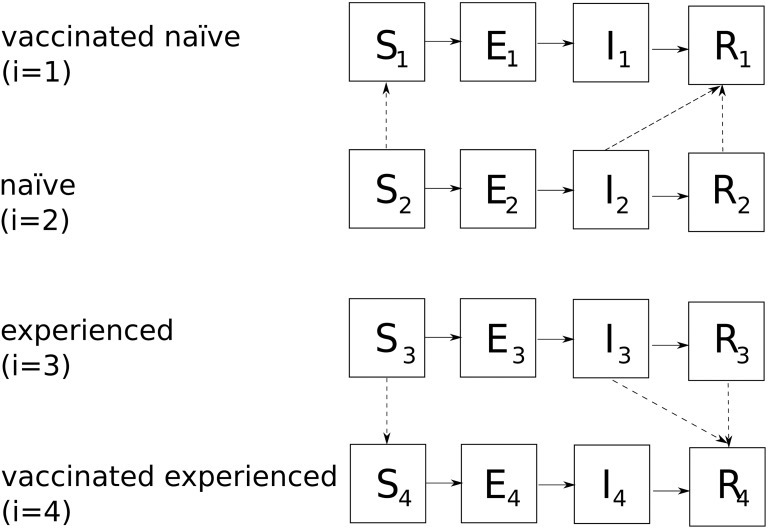
Model structure.Susceptible hosts are divided into 4 strata (labelled by i) depending on their prior influenza experience and vaccination status. Susceptible hosts S
i become exposed (E
i) at a rate proportional to β
f, become infectious (I
i) with Erlang distributed waiting time with rate parameter γ = 1/(1.3 days) and recover (R
i) at a rate ν = 1/(1.6 days). Dashed lines indicate the vaccination of hosts. Note we assume that vaccines do not alter the infectiousness of already exposed hosts (although this distinction is of little consequence if vaccination occurs very early in a pandemic). We allow for the possibility of strain-specific antibody to the pandemic strain by assuming that some (experienced) hosts begin in the recovered state R
3. We assume infected-acquired immunity is maintained over the course of the simulation, however in practice as immunity wanes recovered hosts who were originally naïve migrate to the appropriate experienced susceptible state (R
1 → R
4, R
2 → R
3).